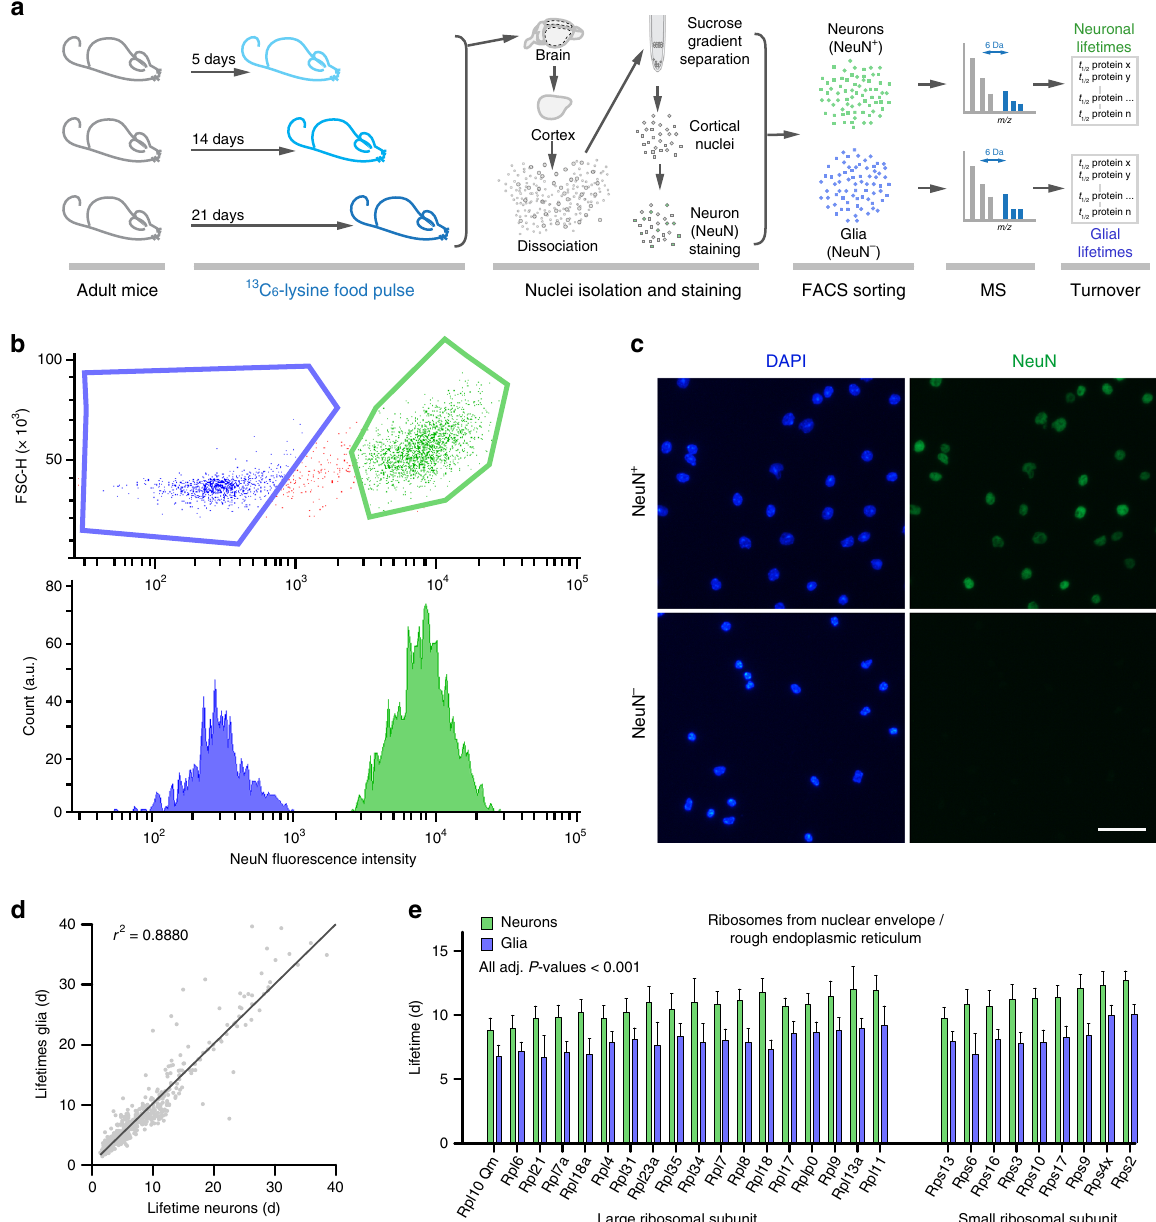
Fig. 4 Lifetimes of proteins from sorted neuronal and glia cell nuclei. a Schematic representation of the pulsing strategy, followed by fl uorescence-activated cell sorting (FACS), mass spectrometry analysis, and lifetime determination. b Representative scatter plot of sorting events, with the positive (green) and negative (blue) sorted populations highlighted vs. the forward scatter height (FSC-H). c Representative images of sorted neuronal (NeuN + ) and glial (NeuN − ) nuclei. d Scatter plot of protein lifetimes for neuronal and in glial nuclei. e Detailed lifetimes for components of the large and of the small ribosomal subunit. All differences are signi fi cant, with a Bonferroni adjusted P -value < 0.001. In all cases the ribosomes that are enriched in the nuclear envelope/rough endoplasmic reticulum are shorter-lived in glial cells than in neurons. See also Supplementary Data 1 for a detailed list of protein lifetimes in the nuclei of neurons and glial cells. See also Supplementary Fig. 18 for the string analysis of proteins either signi fi cantly longer-lived in neurons or in glial cells. Ribosomal constituents, focal adhesions and nuclear parts are signi fi cantly longer-lived in neurons vs. glial cells. The lower false discovery rates (FDR; an adjusted form of P -value to account for false-positive hits) observed in glia cells indicate that overall there are fewer long-lived groups of proteins in these how protein lifetimes change after physiological perturbation of (Supplementary Fig. 21d), and vice versa (e.g., microtubules in brain activity (Fig. 7, Supplementary Table 2 and Supplementary the cortex, Supplementary Fig. 21e). Data 1). We therefore compared the lifetimes in the cortex with those of environmentally enriched (EE) mice, for both the overall brain homogenate and for the synaptosomal fraction. In both cases the correlation between datasets was very high ( r 2 = 0.97; Fig. 7a, b), albeit several proteins changed their lifetimes